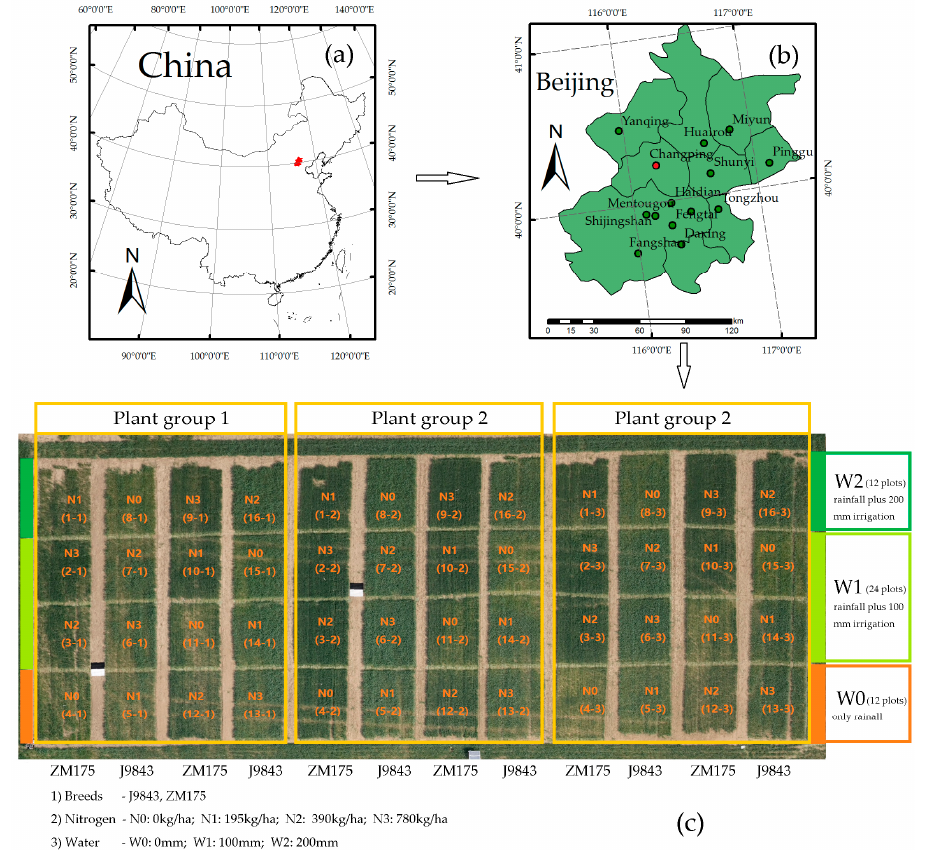
Figure 1. ( a ) Location of study area shown in red. ( b ) Map showing Changping District in Beijing City. ( c ) Design of treatments and an unmanned-aerial-vehicle image of the experimental field (acquired on 12 May 2015). Three plant groups are present with two winter wheat varieties (J9843 and ZM175), three water treatments (W0, W1, and W2), and four nitrogen treatments (N0, N1, N2, and N3).